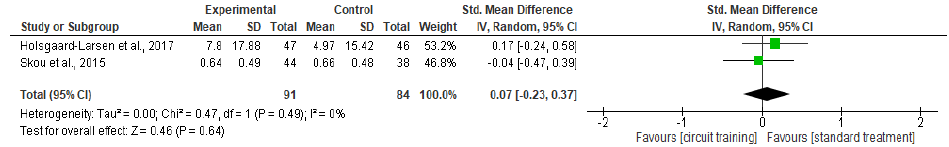
Figure 10. Forest plot analysis of the effect of CT on sports recreation [41,43].